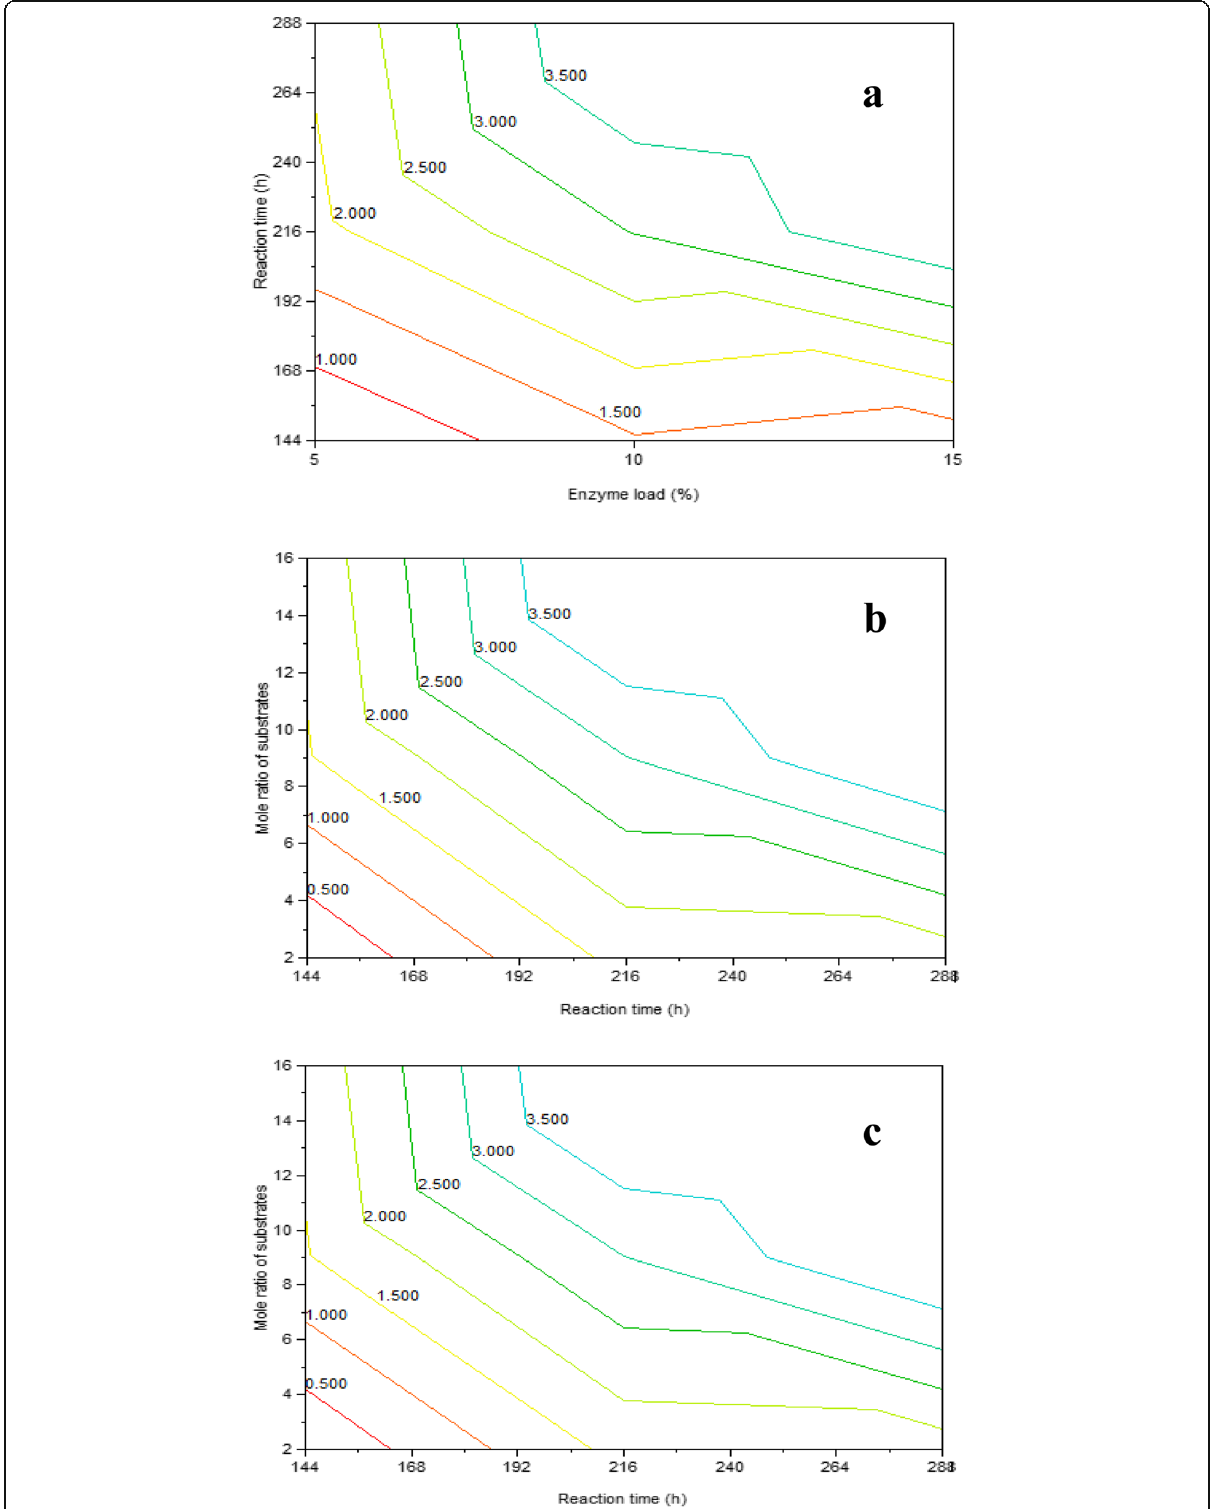
Fig. 5 Contour plots of two tested variables on the degree of esterification of p-coumaric acid; a : reaction time and enzyme load; b : mole ratio of substrates and enzyme load; and c : mole ratio of substrates and reaction